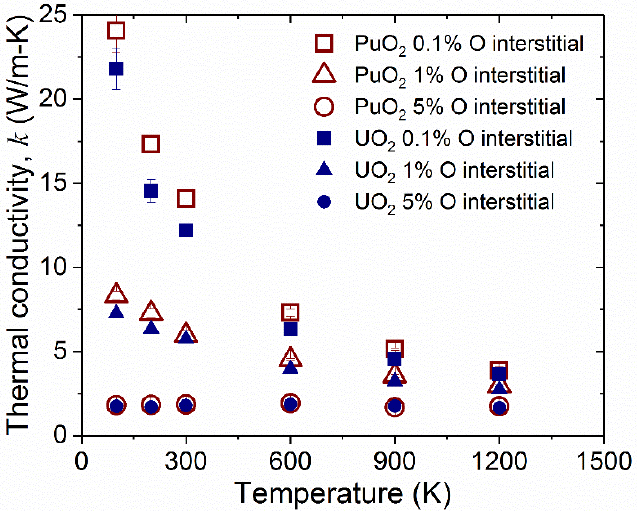
Figure 7. Thermal conductivity of UO 2 /PuO 2 with oxygen interstitials as a function of temperature.